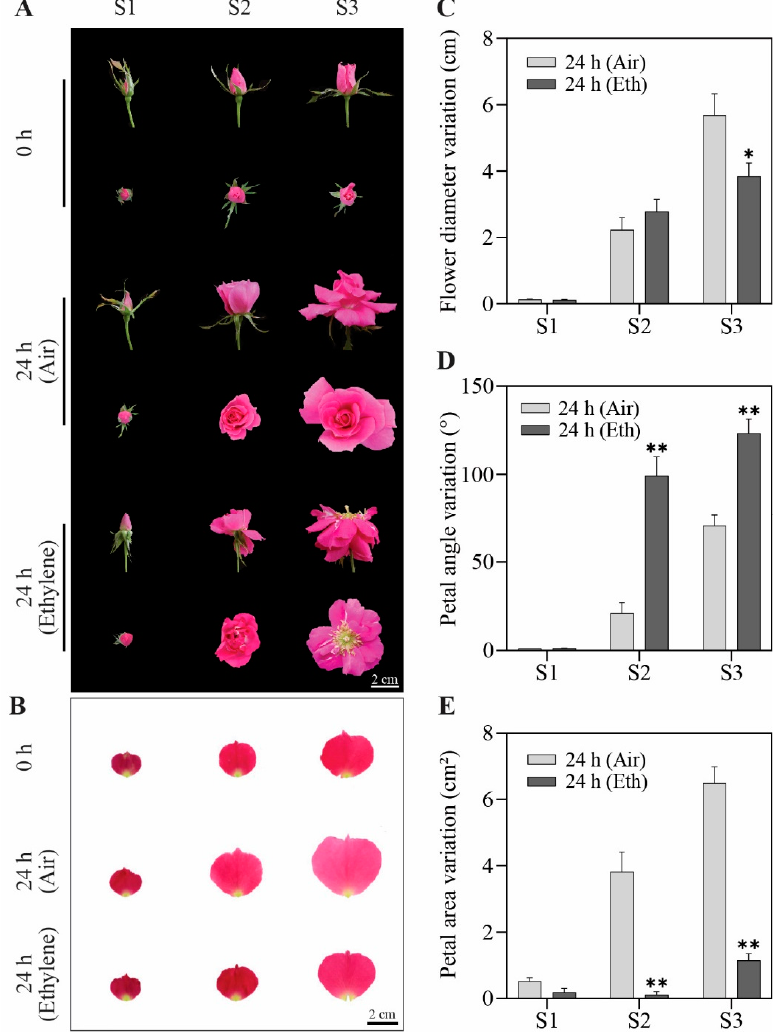
Figure 1. Effect of exogenous ethylene on flower buds at different stages. ( A ) The phenotypes of flower buds at different stages exposed to ethylene or air for 24 h. Stages of flower opening were defined as follows: S1, flower buds with loose sepals (~12-day-old flower buds); S2, flower buds with open sepals (~14-day-old flower buds); S3, flower buds with loose petals (~16-day-old flower buds). First row, side view of flowers; second row, top view of flowers. Bar = 2 cm. ( B ) Petal phenotypes at different stages with air or ethylene treatment for 24 h. Bar = 2 cm. ( C – E ) Quantitative statistics of phenotypes. Flower diameter ( C ), petal angle ( D ), and petal area ( E ) were measured. The results are the mean of three biological replicates ± SD, and asterisks indicate significant differences, in accordance with Mann–Whitney U-test (* p < 0.05; ** p < 0.01).